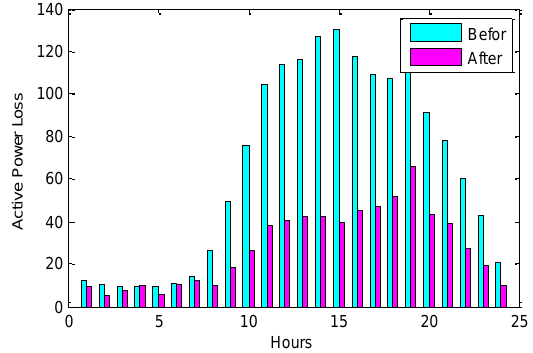
Figure 13. Active power losses for 24 h (first scenario).